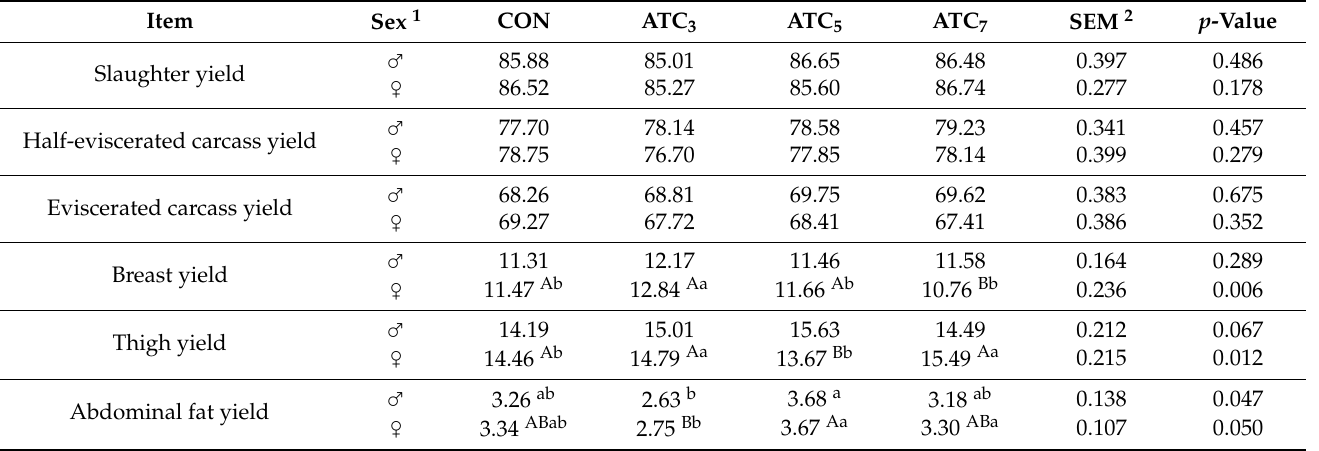
Table 3. Effects of ATC on the slaughter performance (%) of geese ( n =